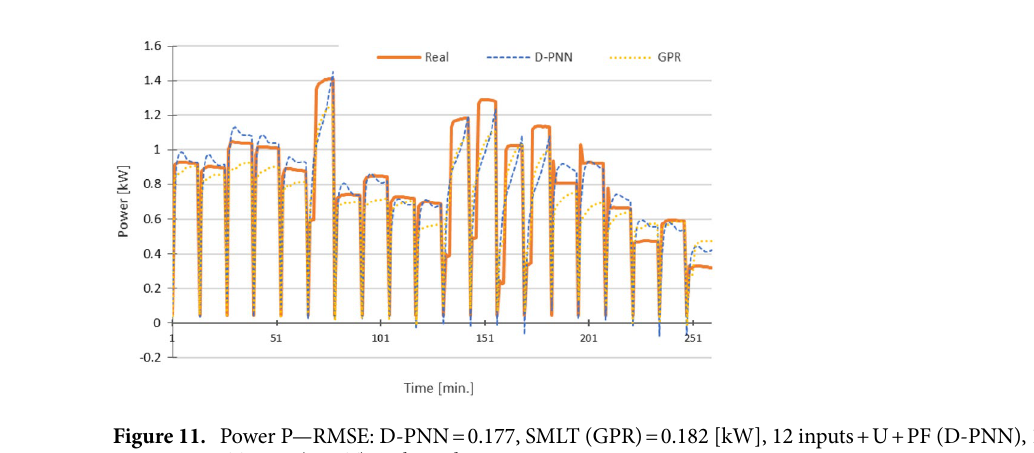
Figure 10. Voltage U—RMSE: D-PNN = 1.153, SMLT (Tree) = 1.118 [V], 12 inputs + THDU (both D-PNN and SMLT) in the 2nd stage.